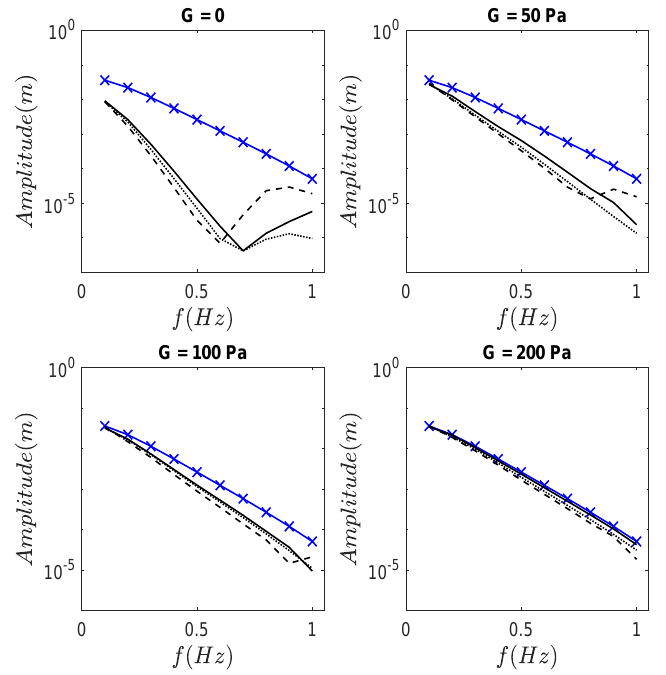
Figure 7. Propagation of cnoidal wave spectrum over mud with shear moduli of G = 0–200 Pa. Blue-solid-x line: the initial spectrum at x = 0, black-solid line: the spectrum with U = + 0.15 m/s, black-dashed line: the spectrum for U = − 0.15 m/s, and black-dot line: the spectrum with U = 0, at the end of mud patch ( x = 800 m), h = 1.00 m, d m = 0.12 m, ρ m = 1111 kg/m 3 , and ζ = 100.